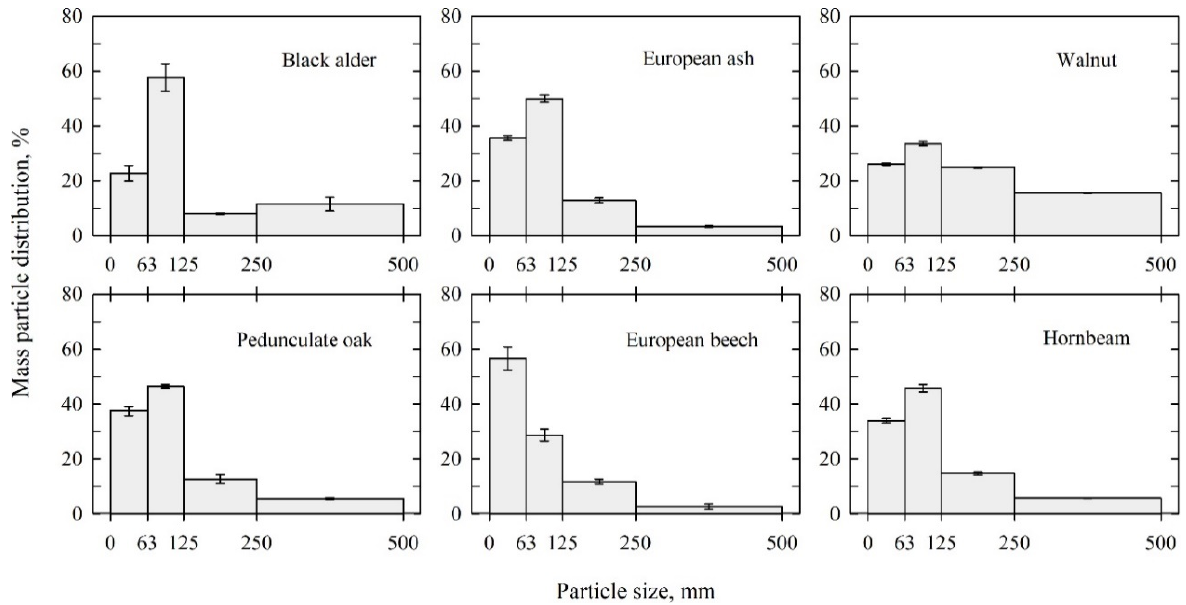
Figure 2. Particle-size distributions of investigated hardwood wood dust by sieving method ( n = 3, error bars represent the standard deviation).